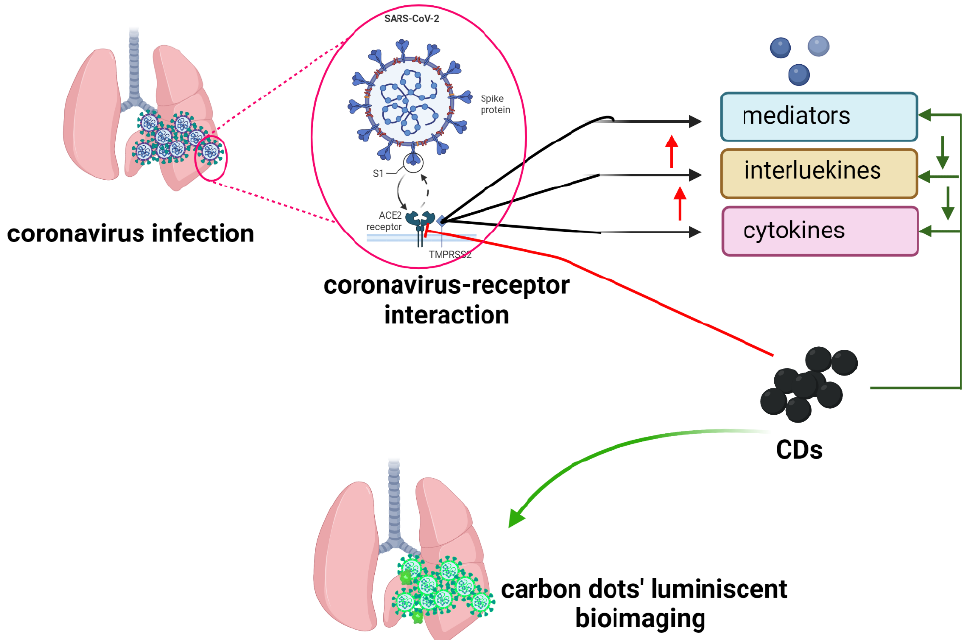
Figure 4. The theranostics role of carbon dots (CDs) in coronavirus infection. CDs prevents corona- virus receptor attachment and, by its fluorescence property, allow for bioimaging of the infected lung. The Figure was created with BioRender.com (accessed on 1 September 2022).